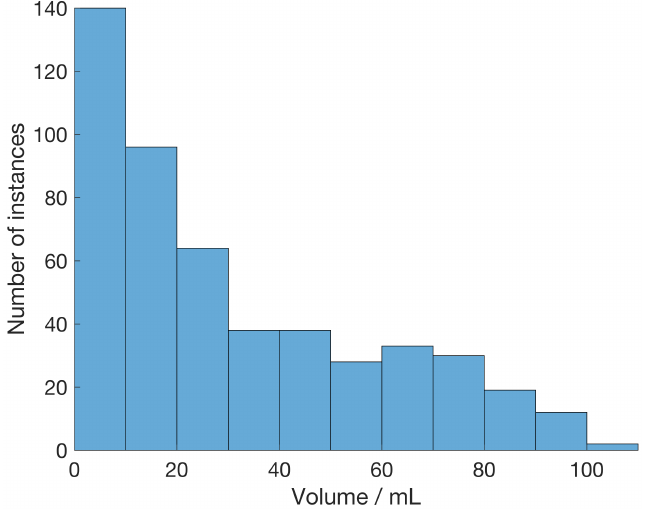
Figure 4. In the simulations, 1000 different head models were used, where 500 with bleeding were included, all within the range 0–105mL. The histogram shows the number of bleeding instances of each volume represented in the dataset with bleeding